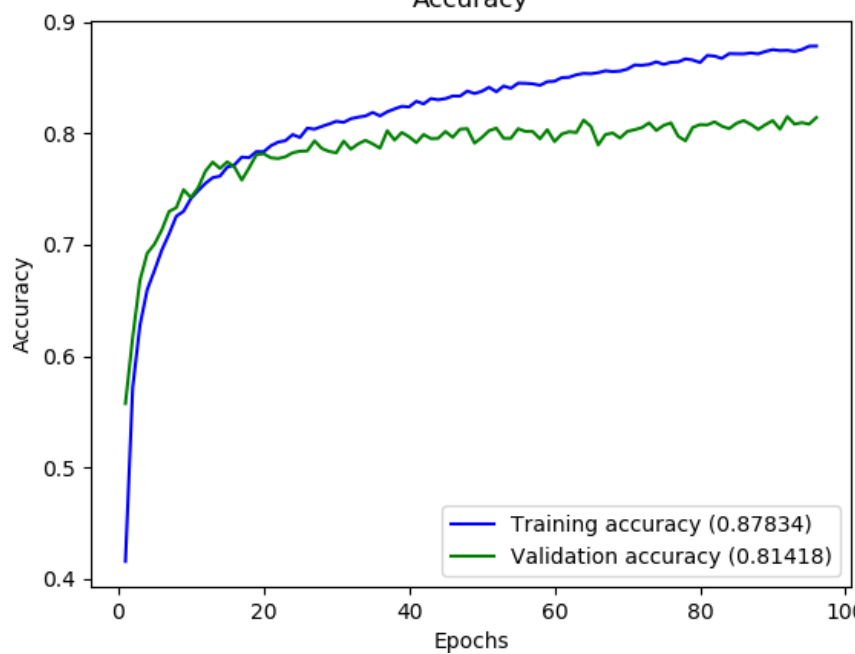
Figure 8. Accuracy graph of the network in [21], trained with the Ensemble 1 database using the data augmentation and the z-score normalization. Figure from